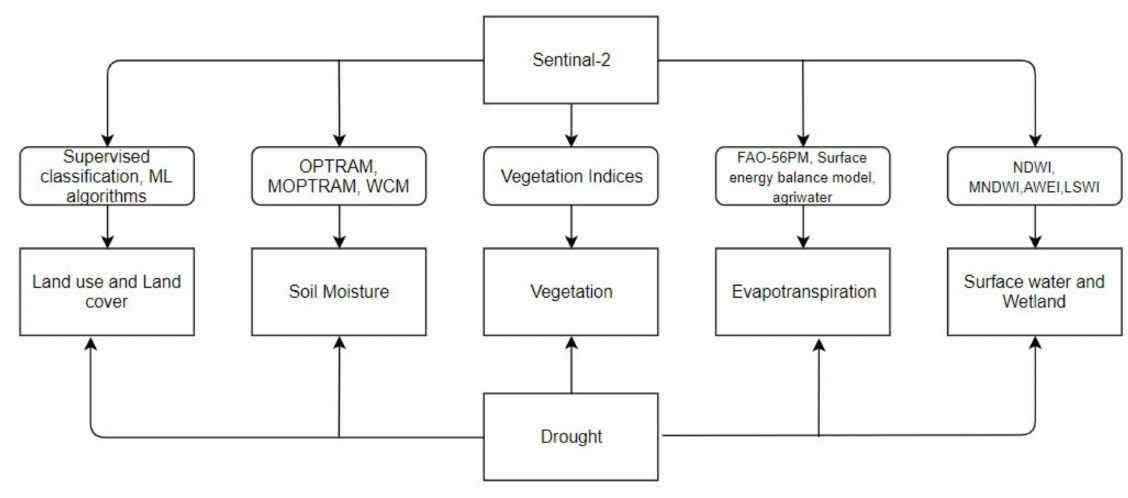
Figure 1. Methodological concept.